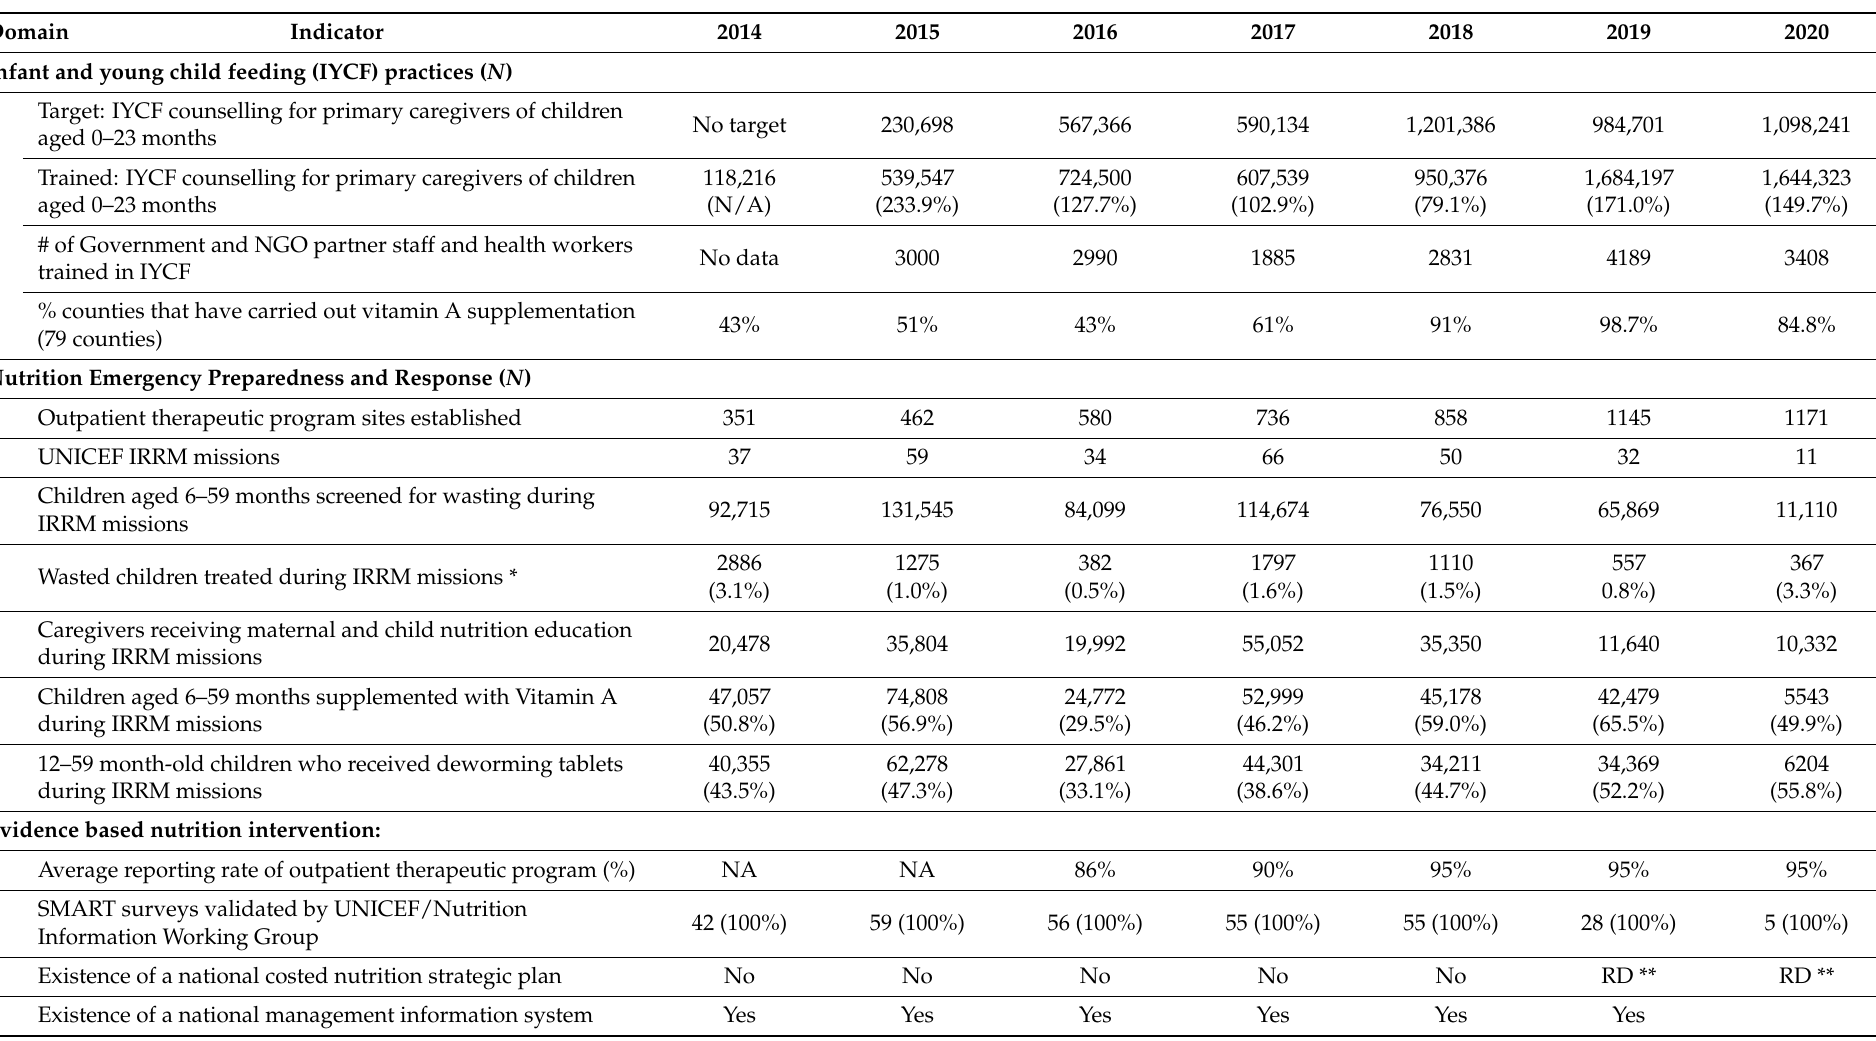
Table 2. Inventory of severe wasting prevention and nutrition emergency preparedness